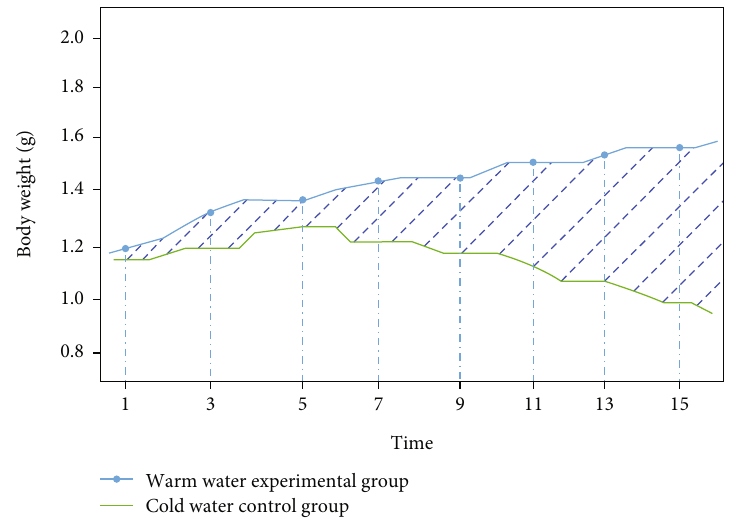
Figure 5: Comparison diagram of average weight change of experimental